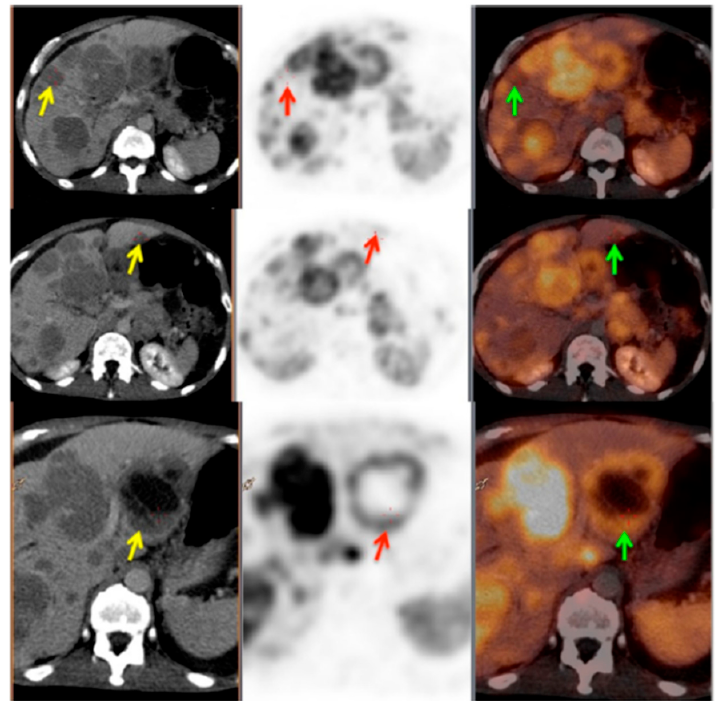
Figure 3. PET/CT image showing somatostatin receptor heterogeneity. Left panel: CT images; middle panel: PET images; right panel: PET/CT fused images. Yellow arrows show the CT lesions in liver; red and green arrows show corresponding lesions on PET and PET/CT fused images, respectively. This patient was characterized as heterogeneous as more than 50% of the target lesions showed heterogeneous somatostatin receptor (SSTR) expression. Reproduced from [104].